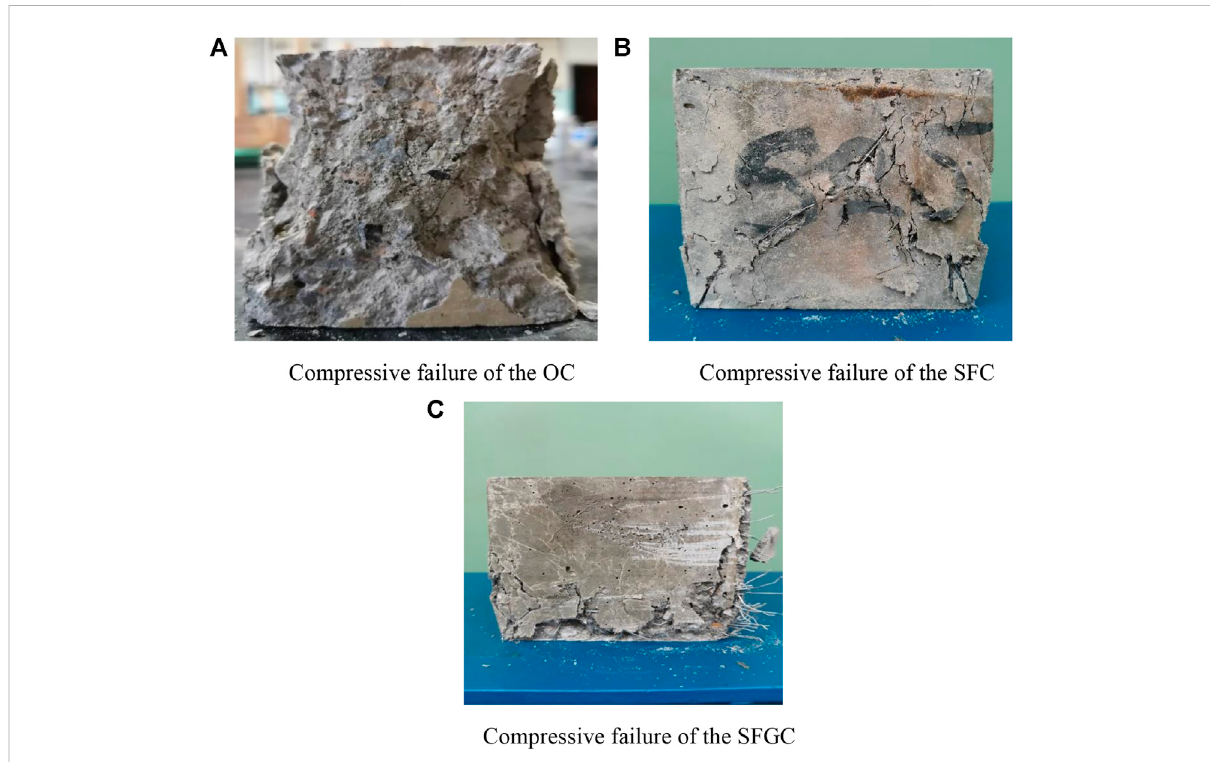
FIGURE 6 Failure of the test blocks. (A) Compressive failure of the OC, (B) Compressive failure of the SFC, (C) Compressive failure of the SFGC